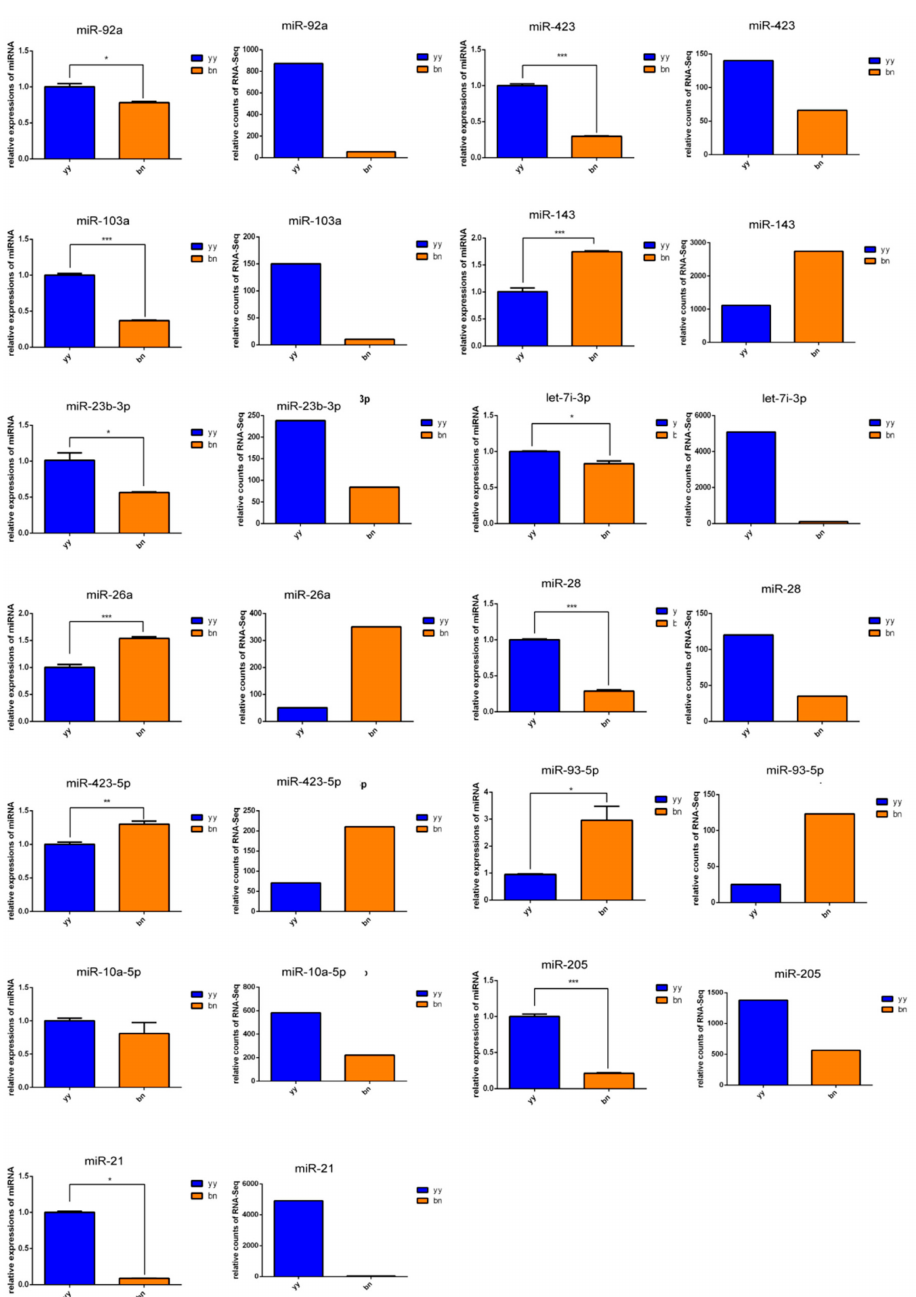
Figure 4. Validation of the HiSeq results through examining the expression levels of 13 DEMs by using qRT-PCR. U6 snRNA were used as reference genes. yy and bn indicated vegetative cells and dormant cysts of P. cristata , respectively. Error bars represent standard deviation of three independent experiments in duplicates. Significant differences compared to the control group are indicated with * p < 0.05; ** p < 0.01; *** p <